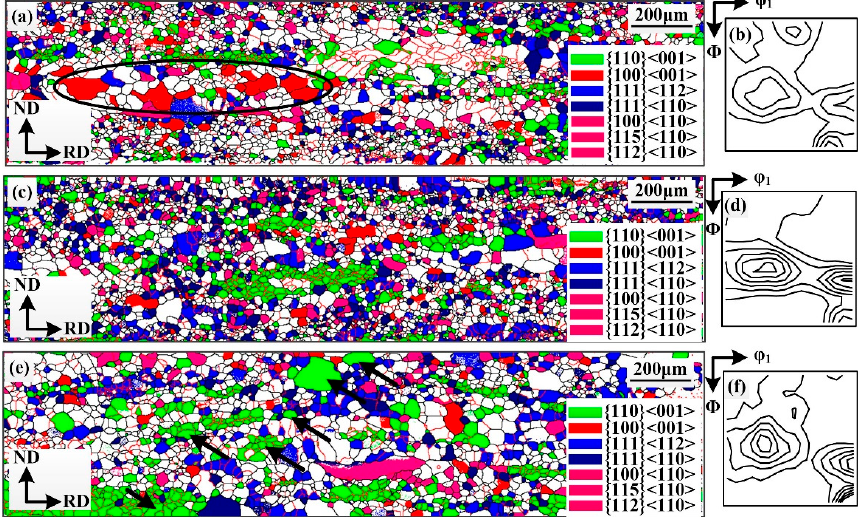
Figure 1. EBSD mainly orientation maps ( a , c,e ) and the corresponding φ 2 = 45° sections of ODFs of intermediate sheets annealed at 1000 °C for different times. ( a , b ) 15 min; ( c , d ) 2 h; ( e , f ) 20 h.